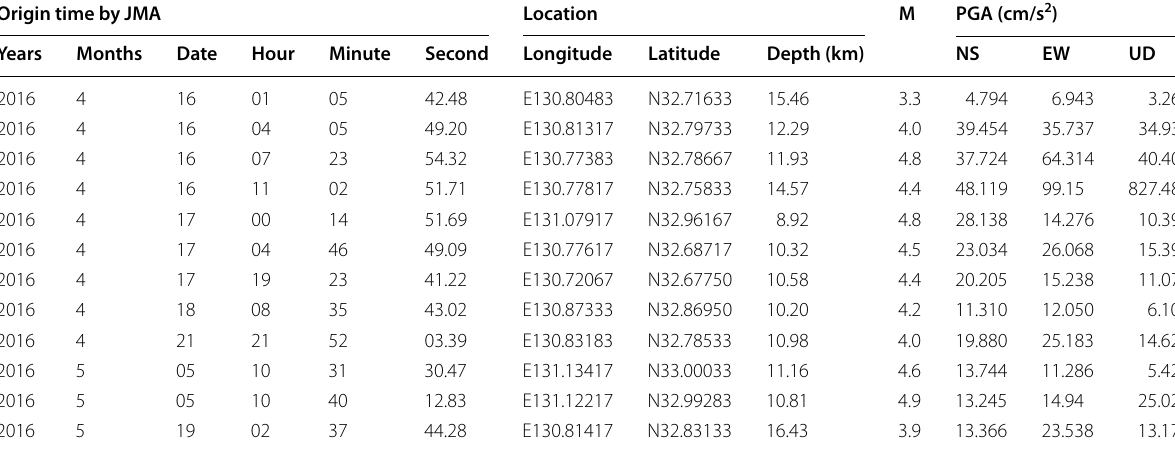
Table 2 Specifications of distributed earthquake data at KUMA Origin time by JMA